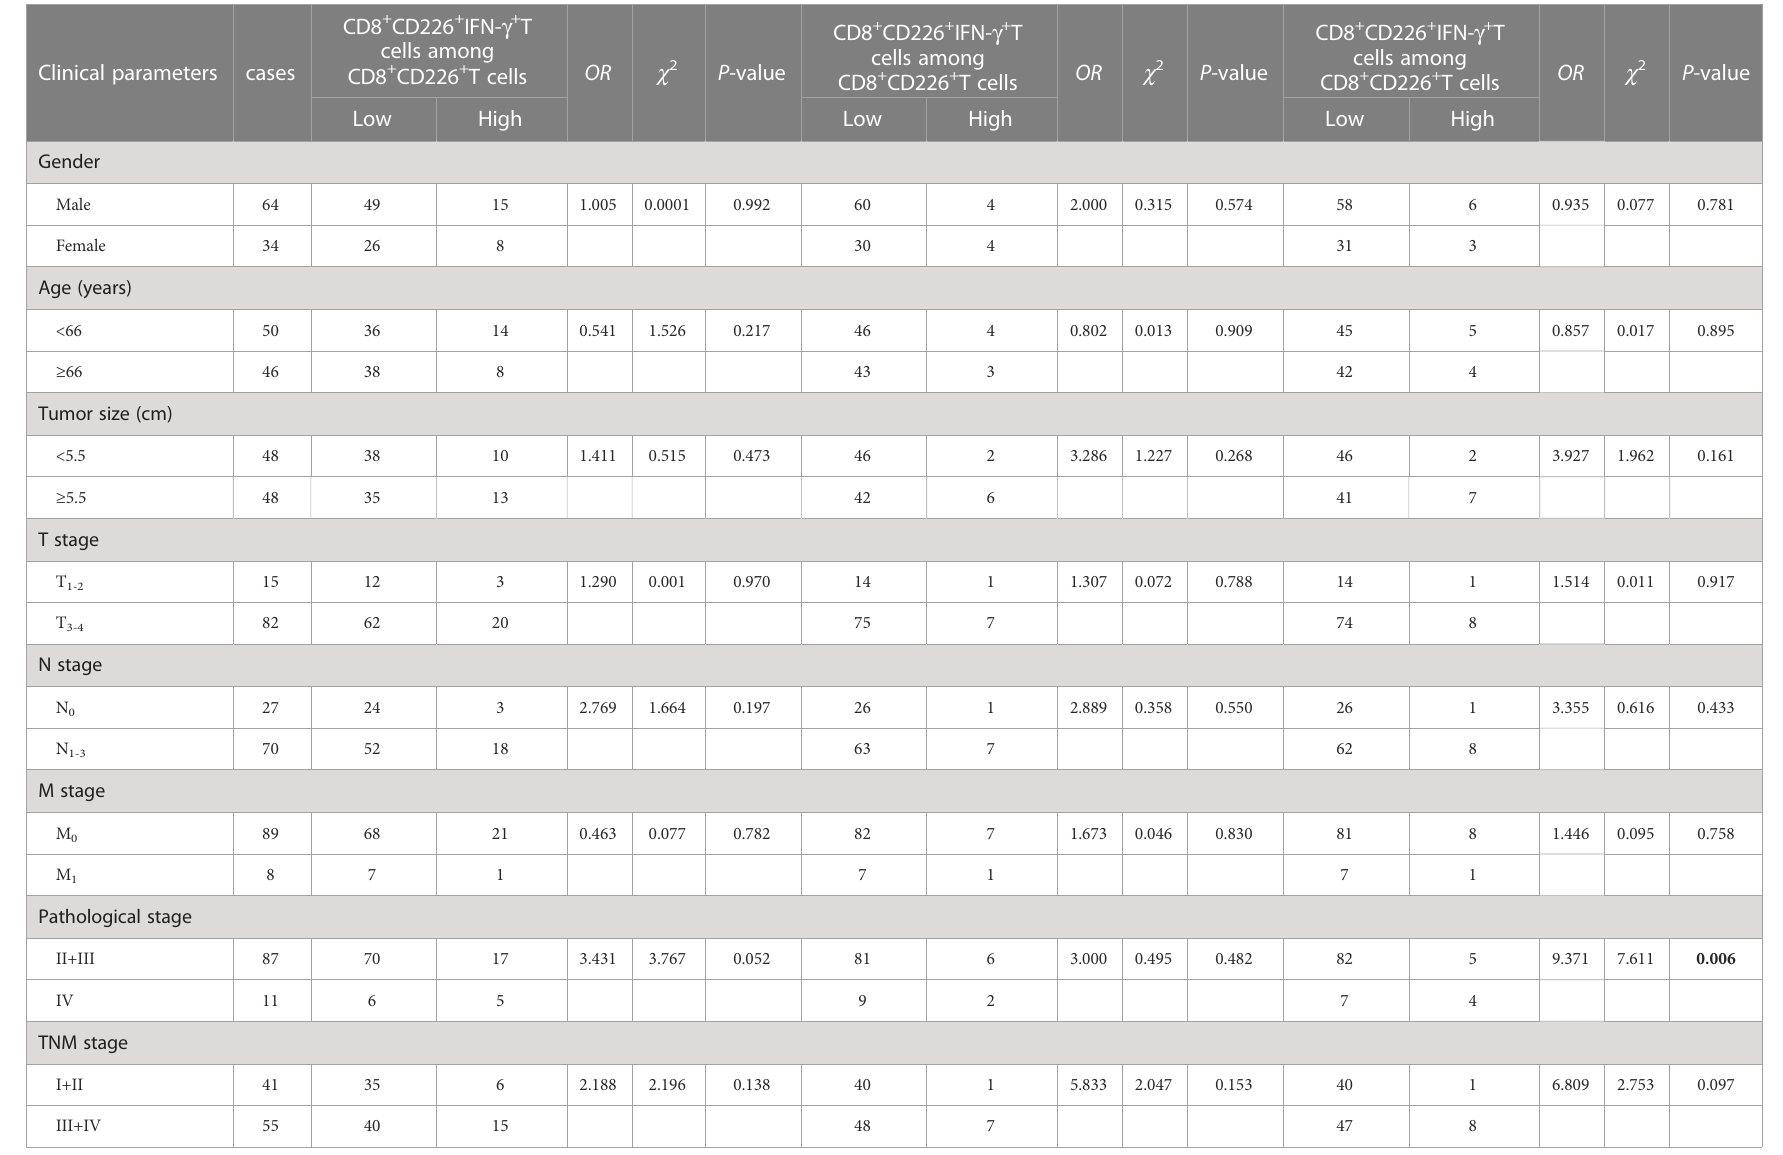
TABLE 5 The association between the percentages of CD226 + CD8 + IFN- g + T cells/CD8 + CD226 + T cells, CD226 + CD8 + IFN- g + T cells/CD8 + CD226 + T cells in the epithelial cell region, and CD226 + CD8 + IFN- g + T cells/ CD8 + CD226 + T cells in the stromal cell region in tumor and clinical features of GC